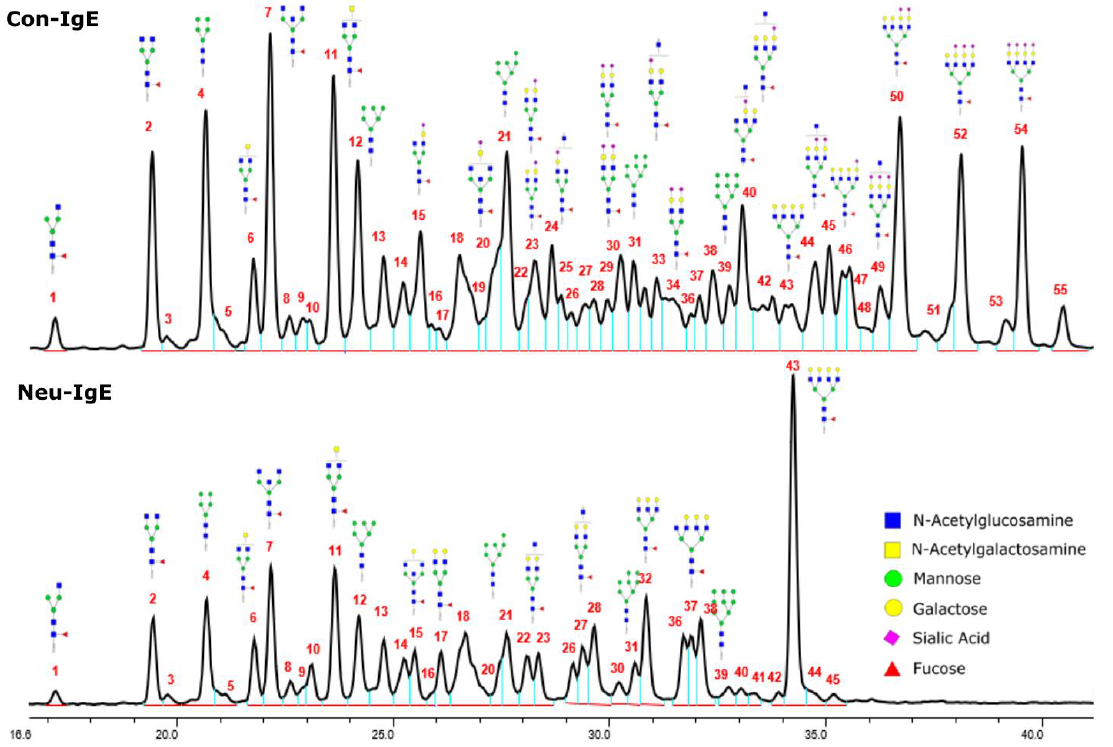
Figure 3. HPLC-FD chromatograms for Con-IgE and Neu-IgE, with suggested glycan structures assigned to main peaks based on m/z masses and predicted monosaccharide compositions. Observed m/z with predicted monosaccharide compositions and suggested structures for each labelled peak are shown in Table 1 [Con-IgE] and Table 2 [Neu-IgE].